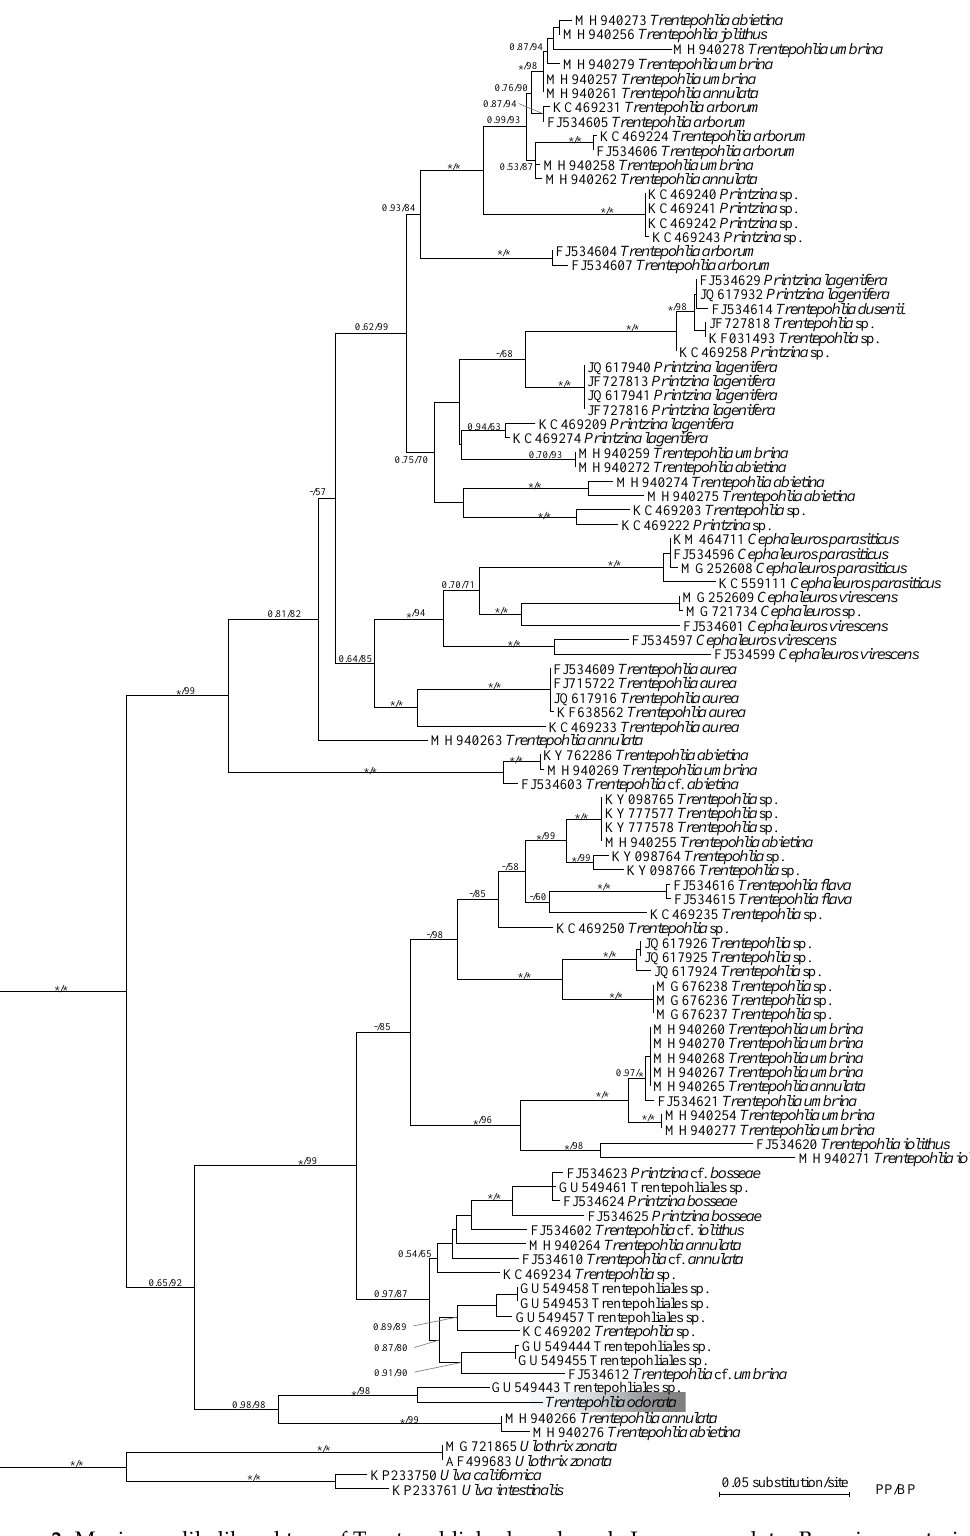
Figure 3. Maximum likelihood tree of Trentepohliales based on rbcL sequence data. Bayesian posterior probability (pp ≥ 0.50) and maximum likelihood (ML ≥ 50) bootstrap values are shown near the branches. The asterisks represent full statistical support (1.00/100). The Trentepohlia odorata was shaded in